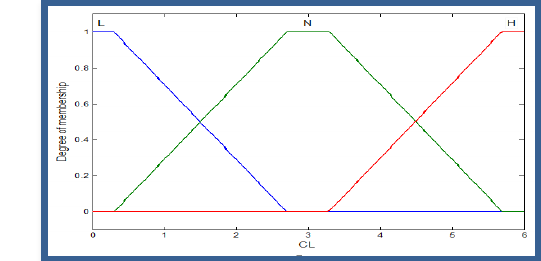
Fig. 7. Membership functions related to temperature (T) – middle model